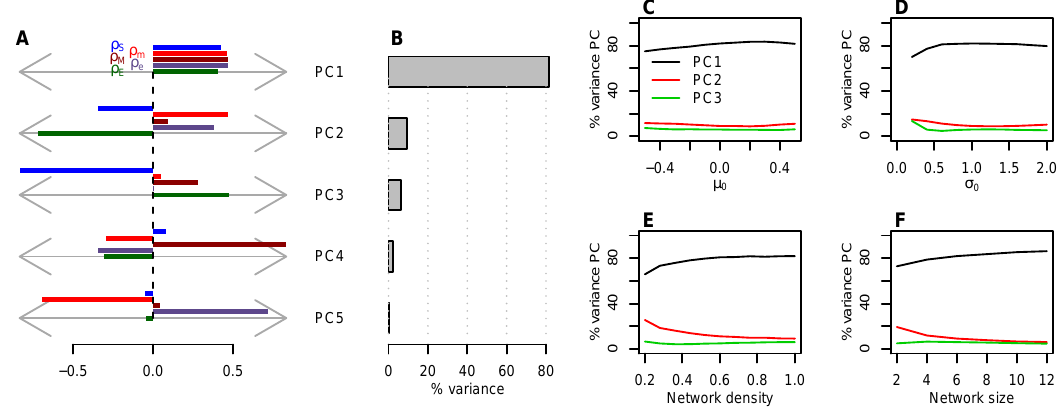
Figure 1 – A: Summary of the principal component analysis on the five robustness indica- tors over 10,000 random 6-gene networks ( µ 0 = 0, σ 0 = 1 ), indicating the position of the five robustness components on all five (normalized) Principal Components (PC); ρ S : Sta- bility, ρ E : Early environmental, ρ e : Late environmental, ρ M : Early genetic, ρ m : Late genetic. B: relative contribution of the five PCs to the total variance. C: Influence of the average regulation strength ( µ 0 ) on the % of the total variance explained by the first PC (negative values feature inhibitory networks, positive values activating networks). D: Influence of the standard deviation of the regulation strength ( σ 0 ). E: Influence of the network